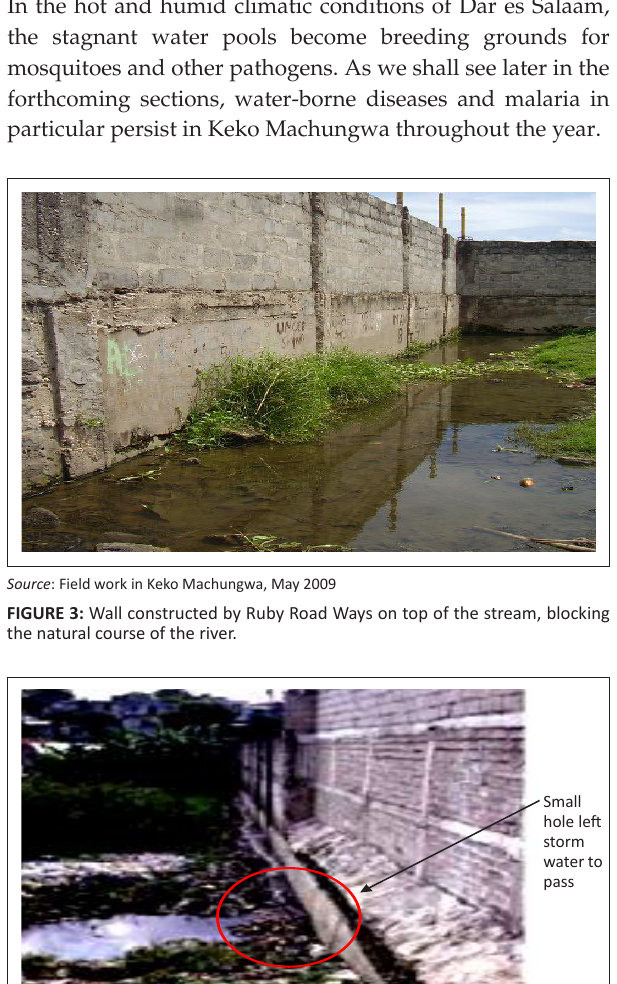
Small hole left for storm water to pass Small hole left storm water to pass